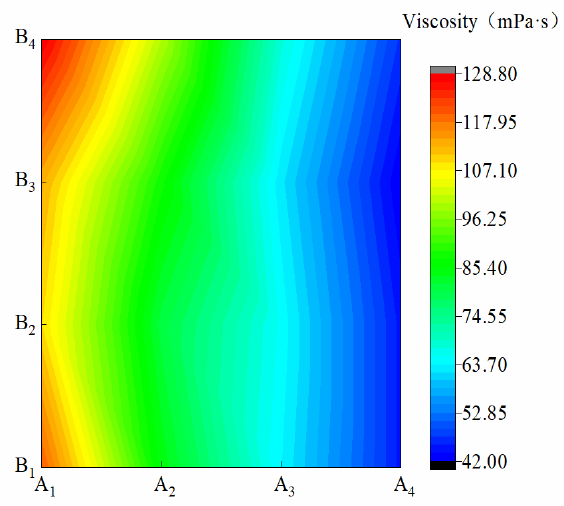
Figure 3. Viscosity of membrane materials under different ratios of water-based copolymer and zeolite amounts.